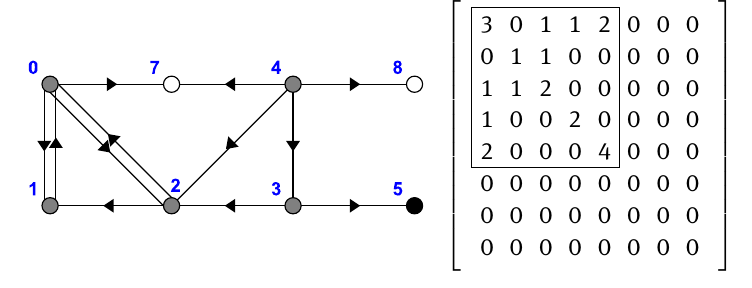
Figure 3: Minimal subdigraph with same block for given